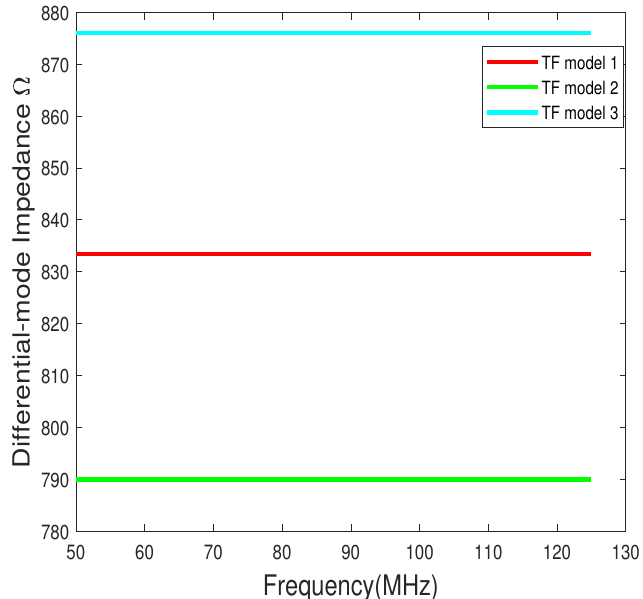
Figure 17. Differential mode characteristic impedance of two-fold (TF) antenna models with respect to frequency. TF models 4 will show similar characteristic impedance as TF model